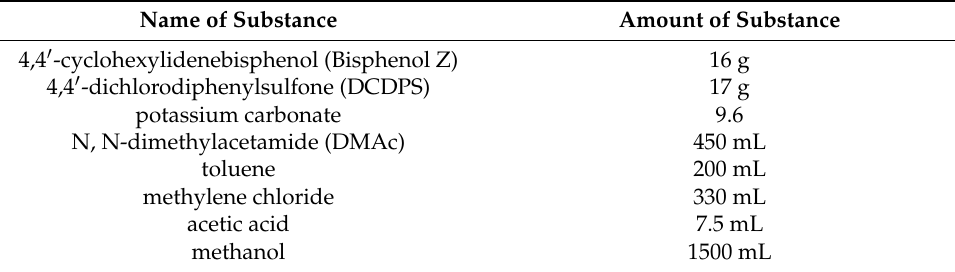
Table 2. Amounts of chemical compounds used for bisphenol Z polysulfone